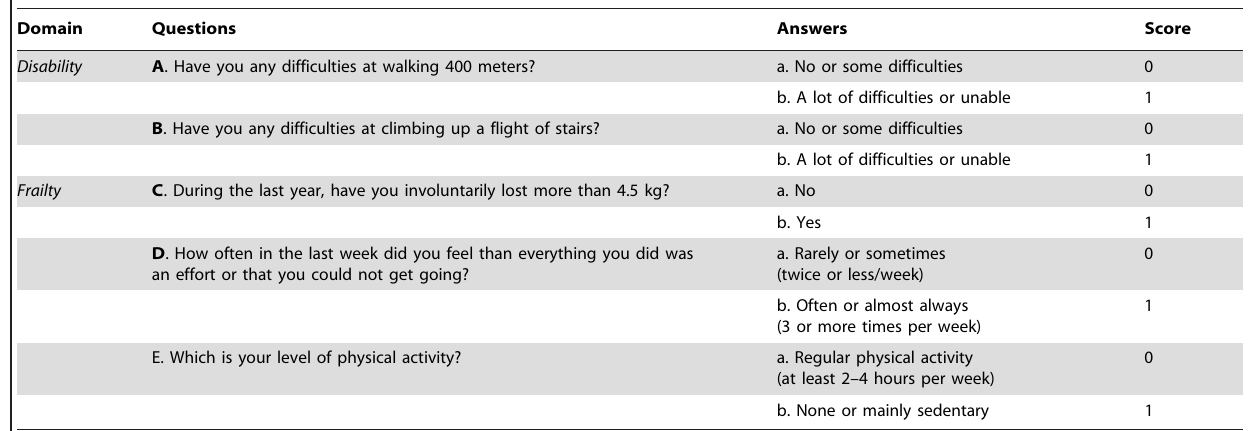
Table 1. The FiND